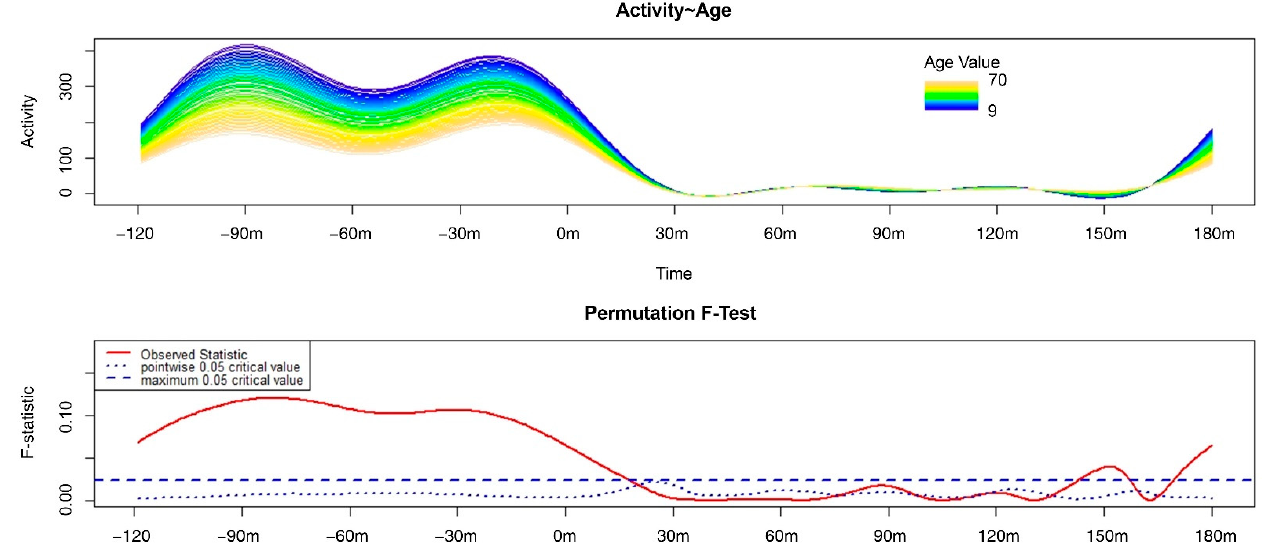
Figure 1. Results of the functional linear modeling applied to the exam of the variation in motor activity patterns of the wake–sleep transition according to age. In detail, the upper panel shows the variation in motor activity of each participant 120 min before and 180 min after bedtime according to age, with blue indicating the lowest and pink indicating the highest age. The lower panel shows the results of the non-parametric permutation F-test with significant differences when the solid red line (the observed statistics) is above both the dotted and dashed blue lines (the global and point-wise test of significance, respectively).